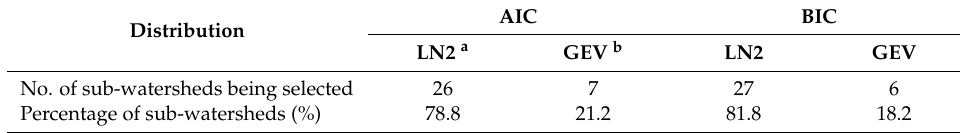
Table 3. Summary of the goodness–of–fit tests for the 33 sub-watersheds.